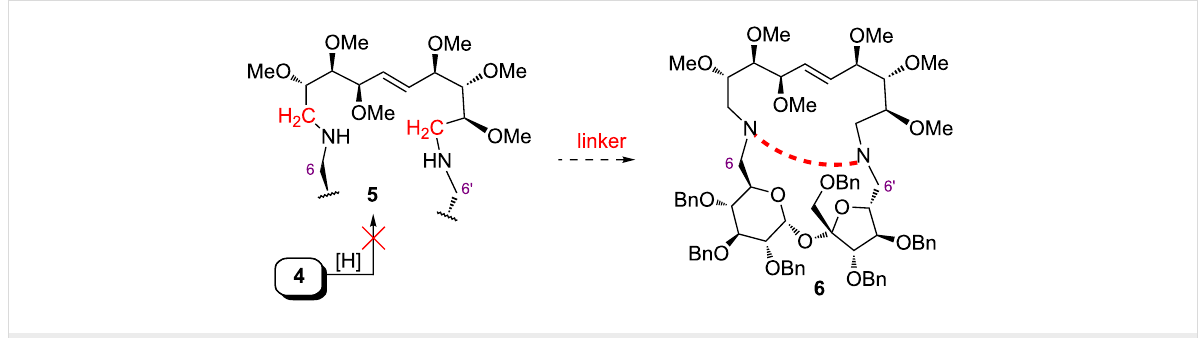
Figure 1: Possible route to sucrose cryptands 6 .